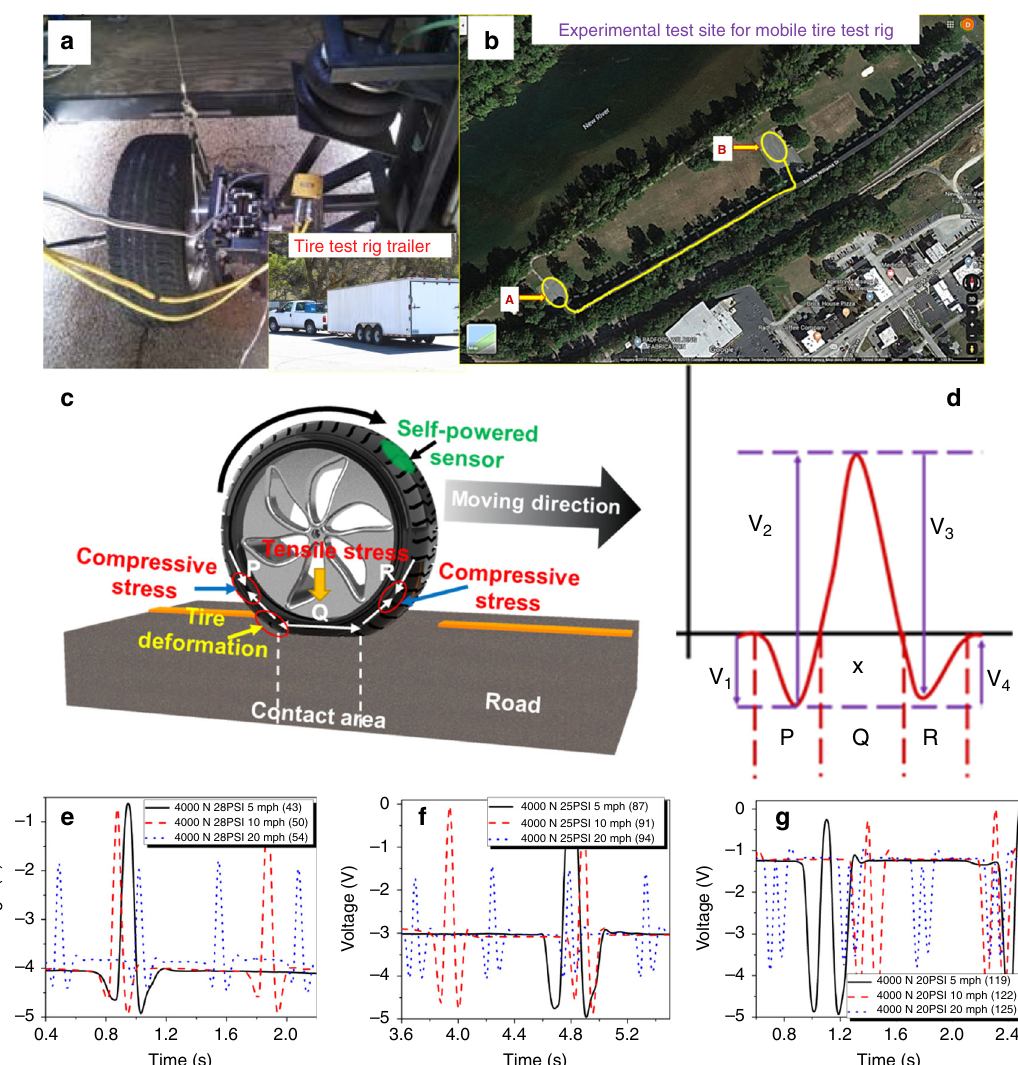
Fig. 3 Field test setup and results of the 3D printed tire sensor. a Mobile tire test rig for testing of the sensors in a real environment. The inset of the a shows that the mobile tire test rig was attached to a towing vehicle. b Satellite map (Courtesy google map) of the experimental test site (Bisset Park, Radford, VA) of the smart tire in a test rig. The measurements were performed on smart tire, while operating test rig between parking A and parking B. c , d Schematics of the tire deformation with different types of strain and corresponding waveform. The varying voltage output across the 3D printed piezoresistive sensor at 4 kN normal load and three different speeds (5, 10, and 20 mph) for e 28 psi, f 25 psi, and g 20